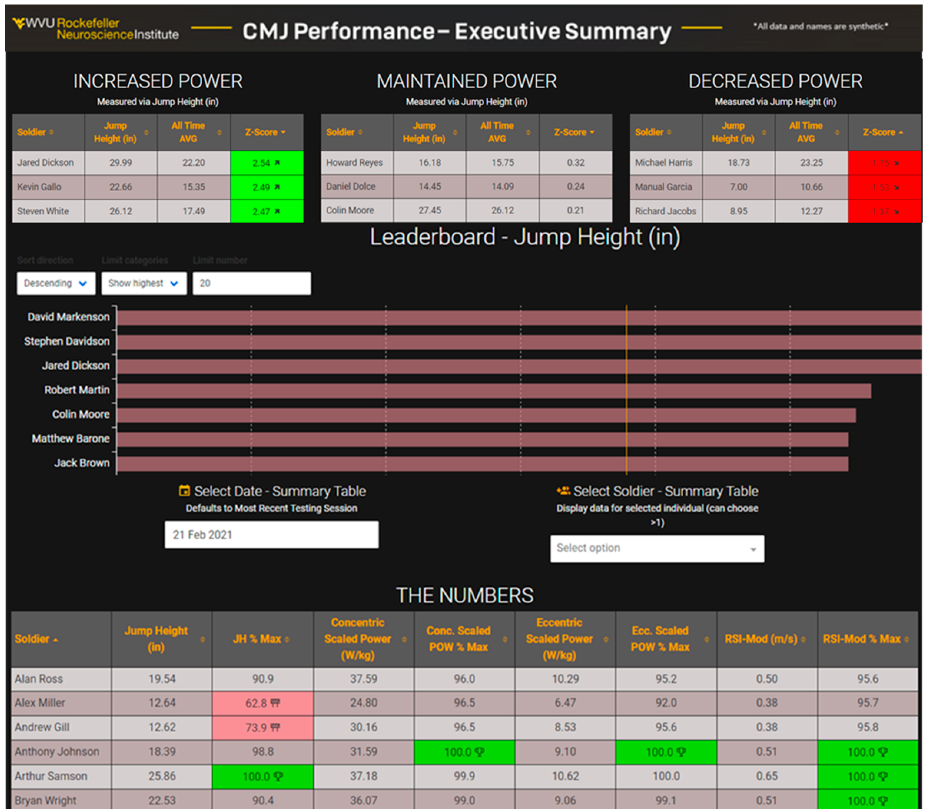
Figure 1. A Fusion Sport Smartabase dashboard built to display comparisons of individuals to their average historical values (identifying those increasing, maintaining, and decreasing in power production capabilities by utilizing jump height Z-scores based on intra-individual variation), others within the group (leaderboard comparisons to the group average), and as a percentage of their all-time personal best record (100% highlighted in green would indicate a personal record while red indicates very low performances compared to historical records). Highlighting groups of individuals with red flag alerts from decreased performances can be used to easily identify and make appropriate adjustments to individual training regimens. This data and names have been synthetically generated for visual